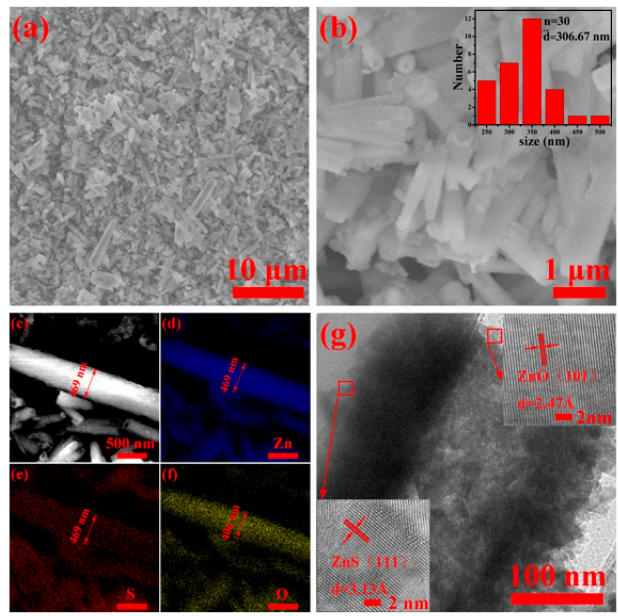
Figure 2. ( a , b ) SEM images of the ZnO@ZnS nanorods at different magnifications and the particle-size distribution of the ZnO@ZnS nanorods; ( c–f ) energy-dispersive X-ray spectroscopy (EDS) mapping showing the distributions of zinc (Zn), sulfur (S) and oxide (O) in the ZnO@ZnS nanorods; ( g ) TEM images of the ZnO@ZnS nanorods at different